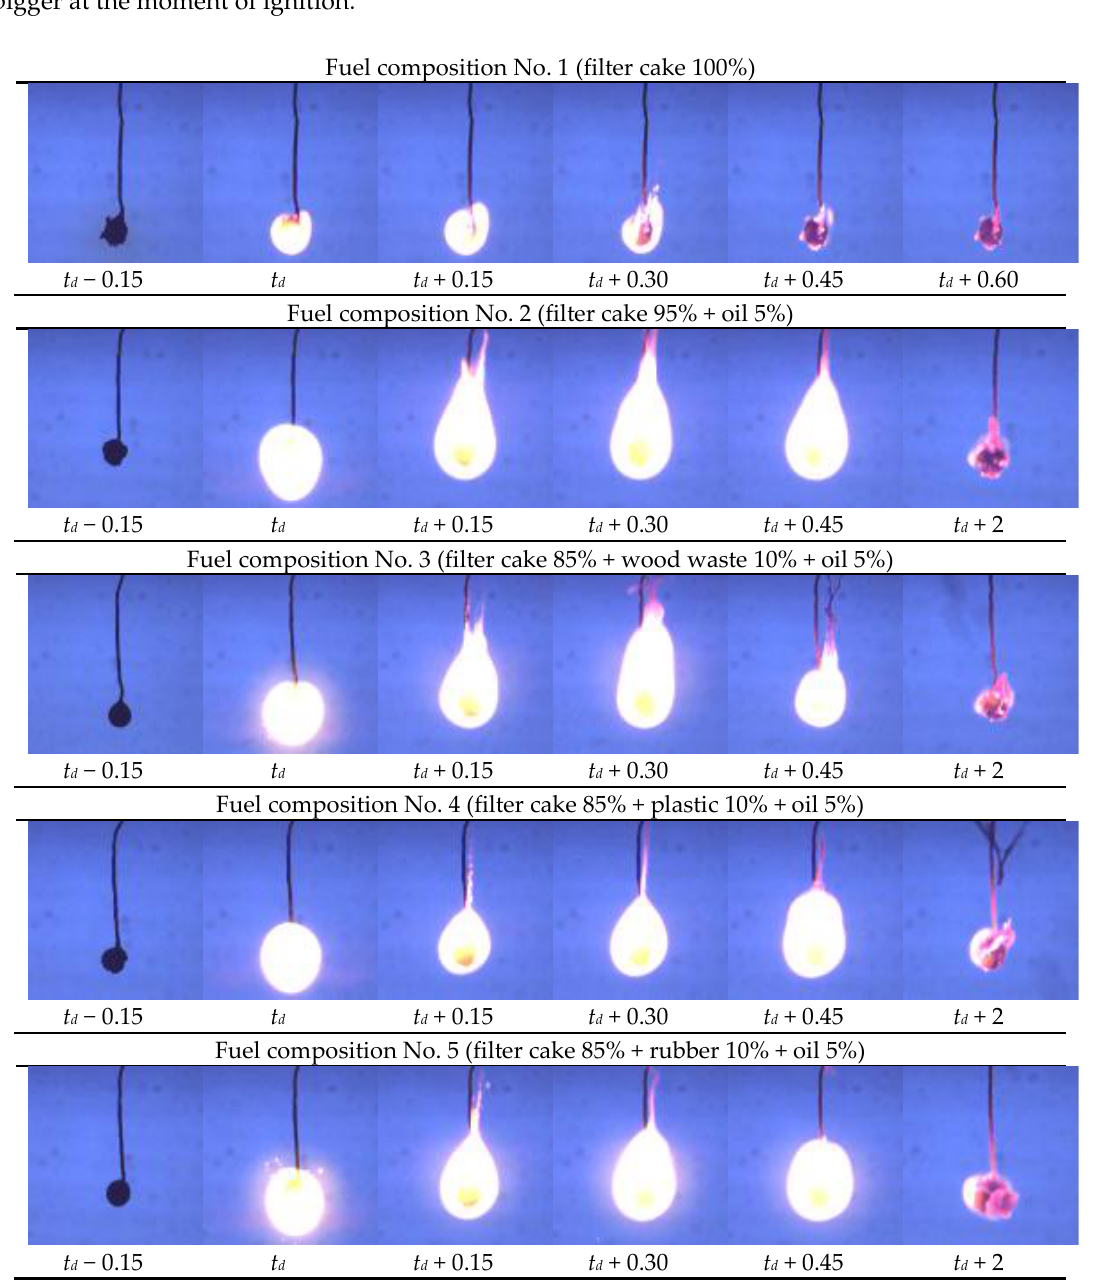
Figure 4. Ignition and combustion of composite liquid fuel droplet at T g = 800 °C ( t d , s). After the ignition, the gas-phase combustion process of the volatiles takes place predominantly above the droplet (Figure 4) where a stoichiometric ratio occurs between the components (oxidizer and fuel) of the gaseous mixtures. The intensity of the flame in the frame with t = ( t d + 0.30) s (Figure 4) is lower in the lower regions of the droplet. The intensity increases when going vertically (upwards from the droplet bottom). It means that a rich premixed flame zone is present in this region, where the oxidizer concentrations are relatively higher than the fuel concentrations [18]. The intensity of evaporation and thermal decomposition of the composite fuel components is quite low. This causes the flame to appear nearer to the droplet surface. As a result, the solid combustible residue is heated by the energy released from the process of the gaseous mixture burnout, and then it ignites. The combustion front is spread inside the droplet from its surface to the center. For the municipal waste investigated in this research, the share of a non-combustible solid residue is much smaller than that for the filter cake (Table 1). Adding MSW into the fuel composition causes not only a pronounced